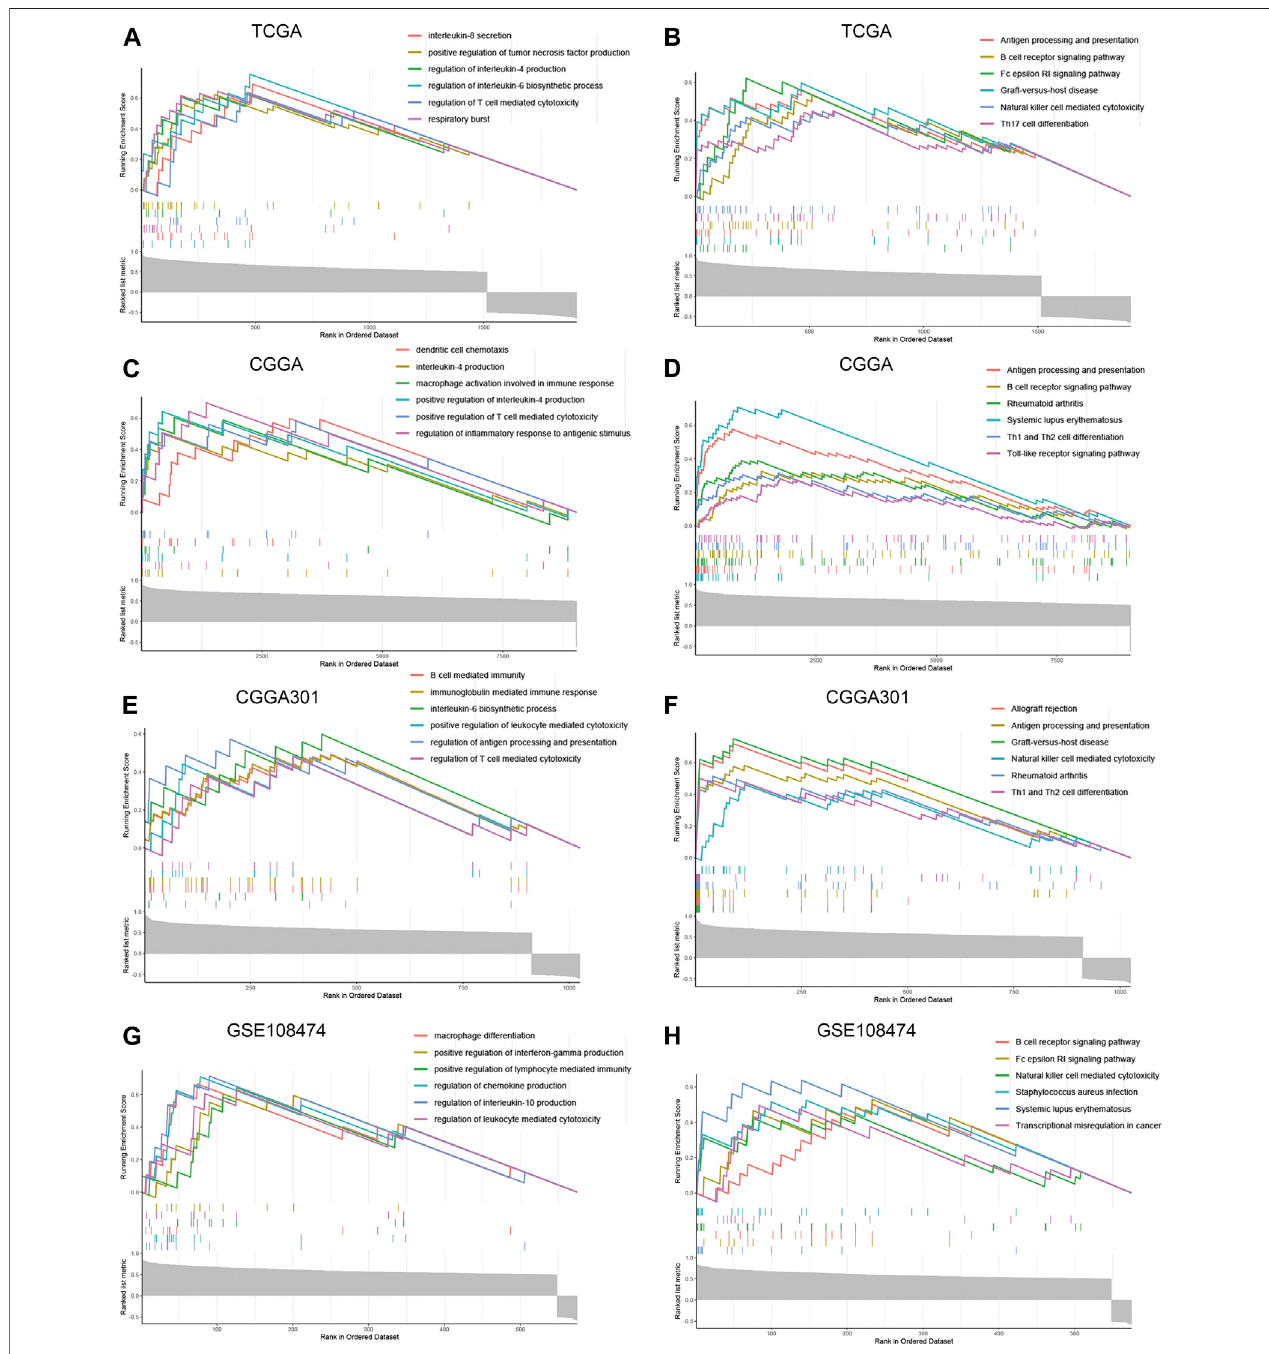
FIGURE 4 | Enrichment analysis of co-expressed genes of CD74. A-H. GSEA enrichment analysis of co-expressed genes of CD74 in GO and KEGG terms in the TCGA (A, B) , CGGA (C, D) , CGGA301 (E, F) , and GSE108474 (G, H) datasets. GO: Gene Ontology; KEGG: Kyoto Encyclopedia of Genes and Genomes.